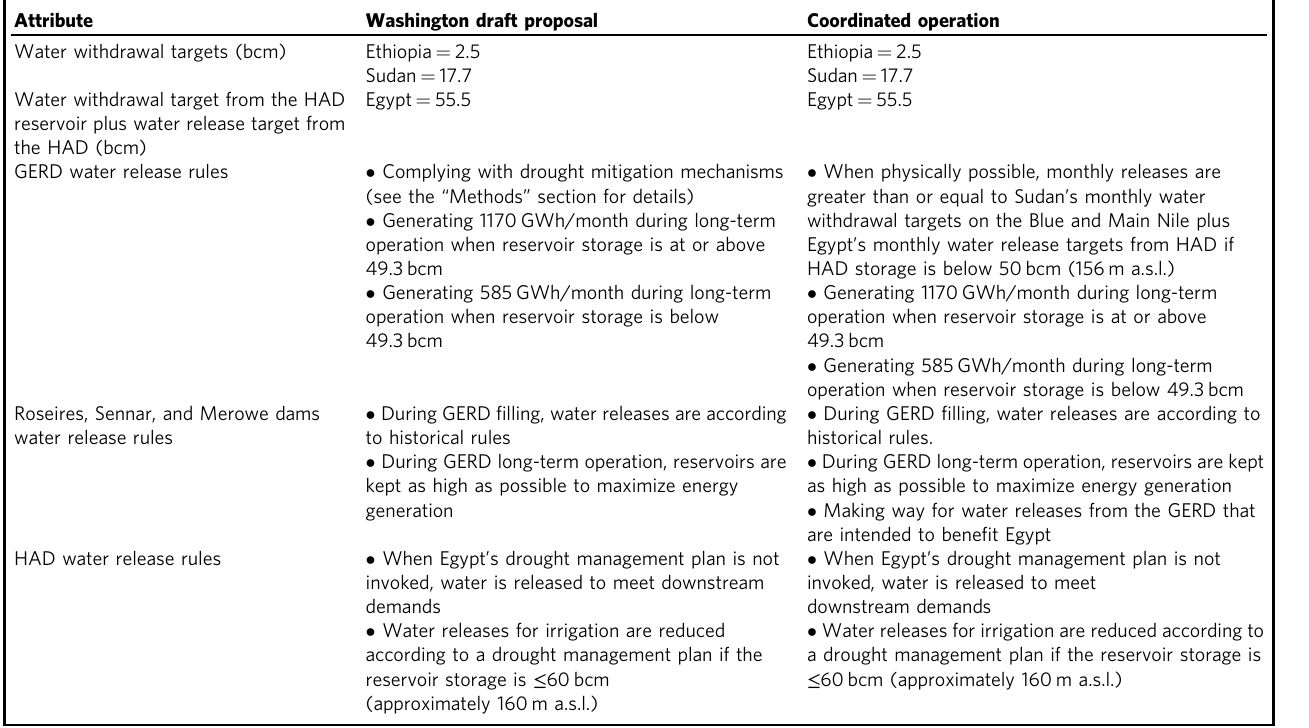
Table 1 Main assumptions and attributes of the Washington draft proposal and coordinated operation.